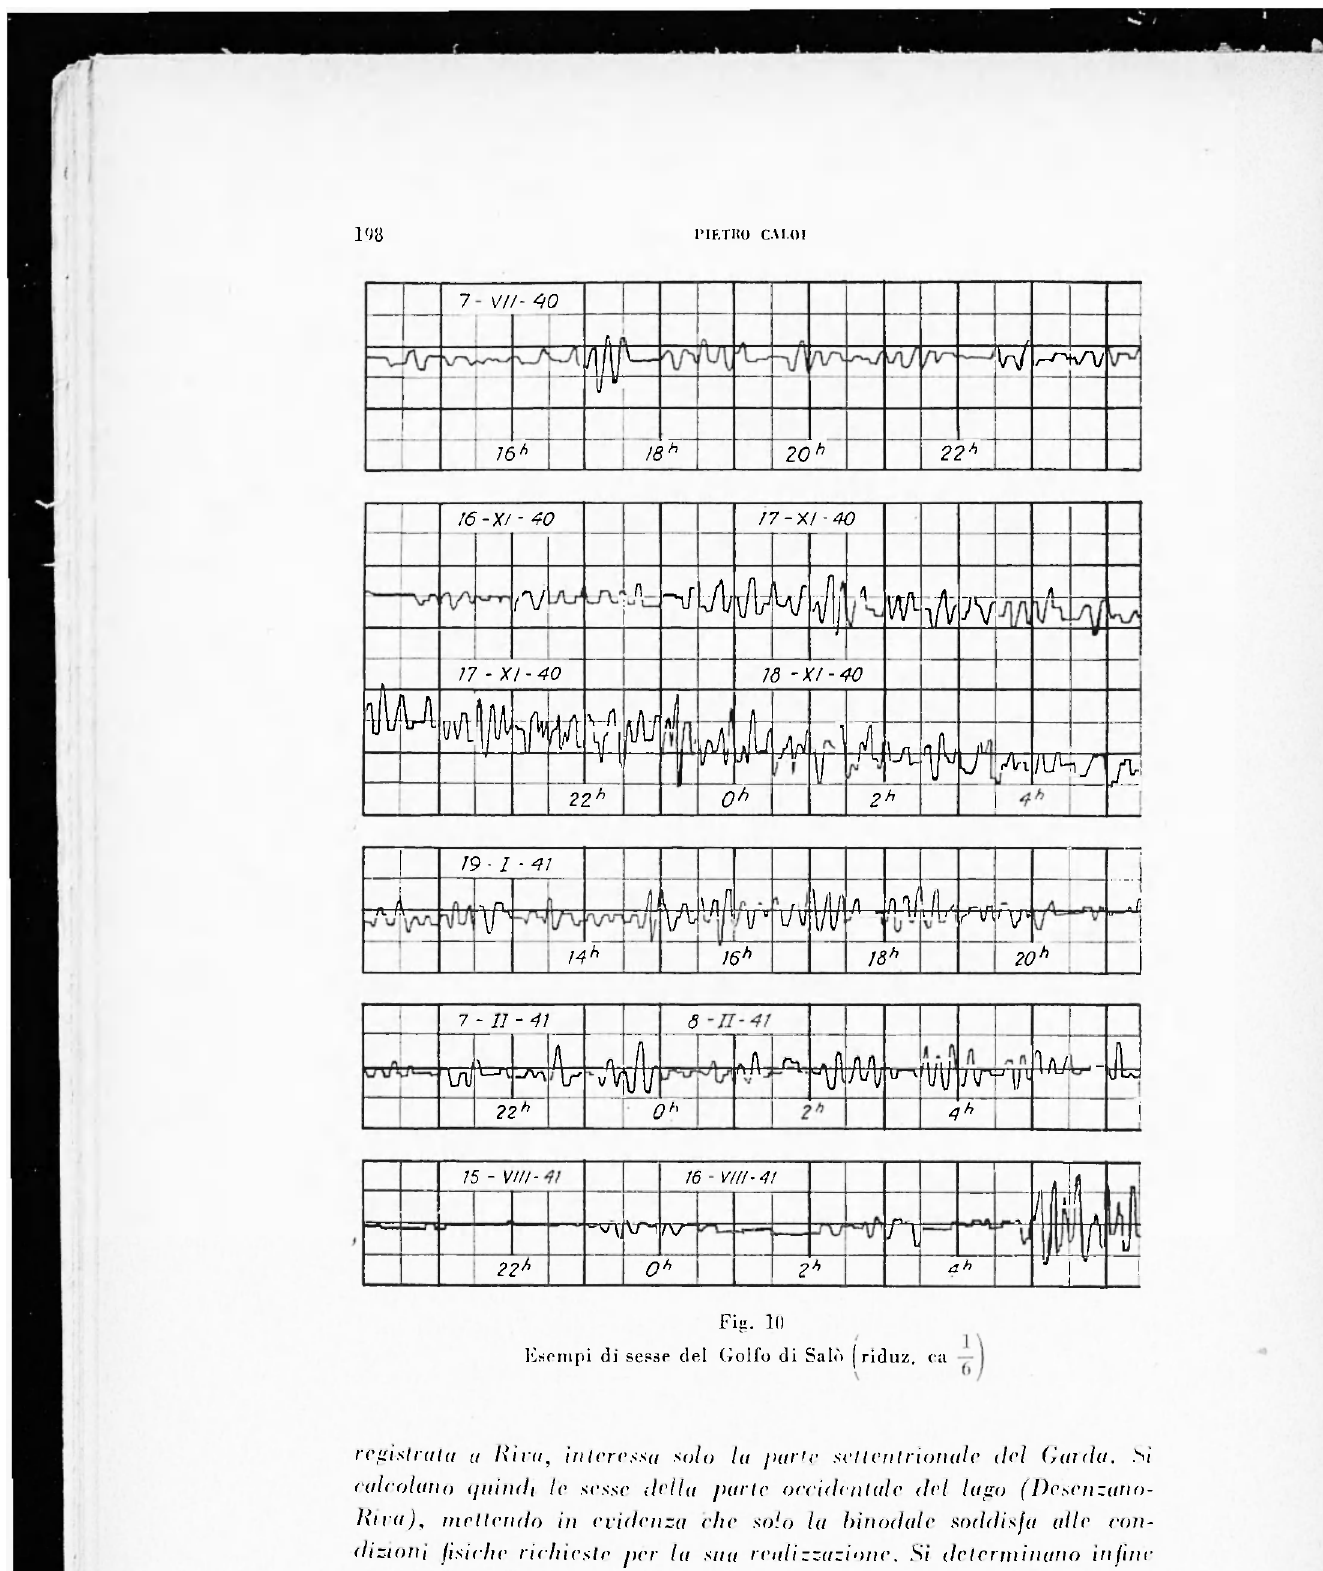
Esempi di sesse del Golfo di Salò (riduz.